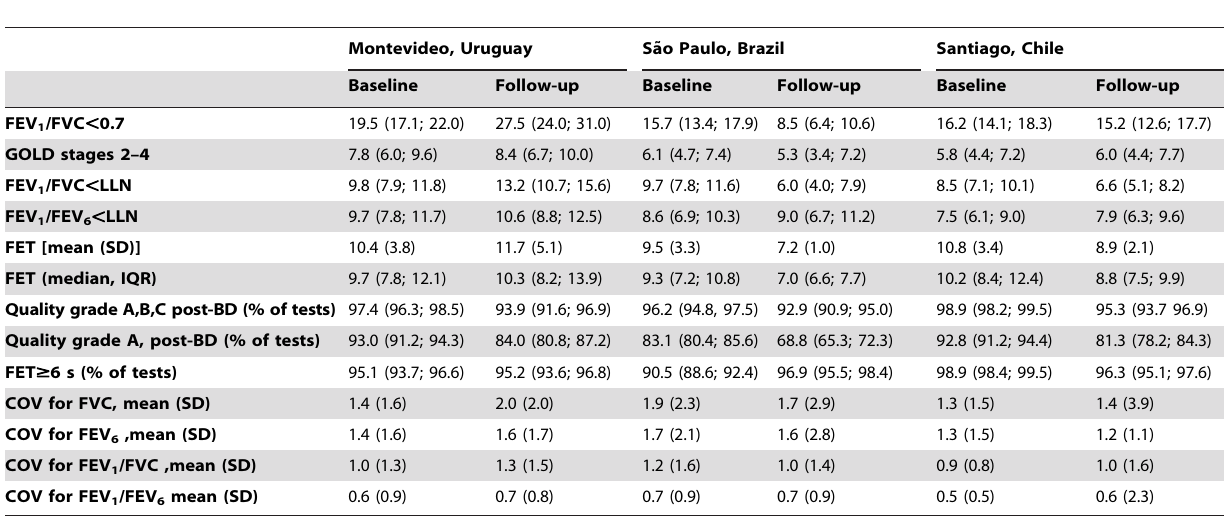
Table 2. Prevalence (%) of post-BD airway obstruction and indices of spirometry quality by study